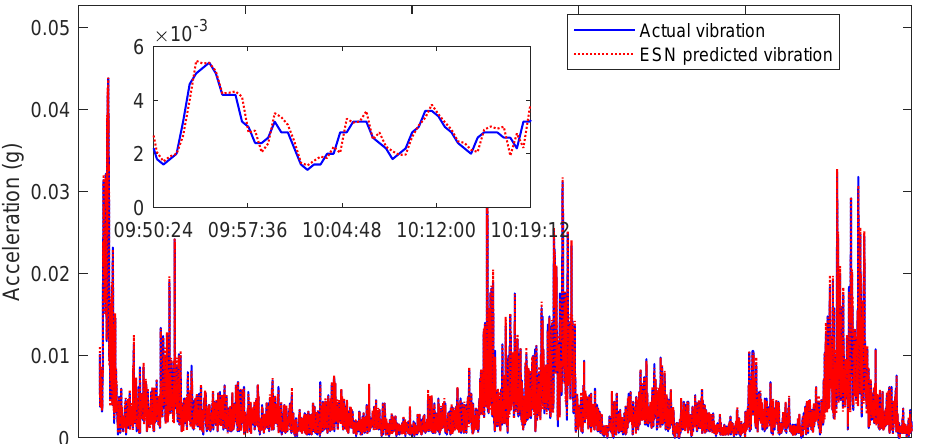
Figure 9. ESN training results for gearbox vibration